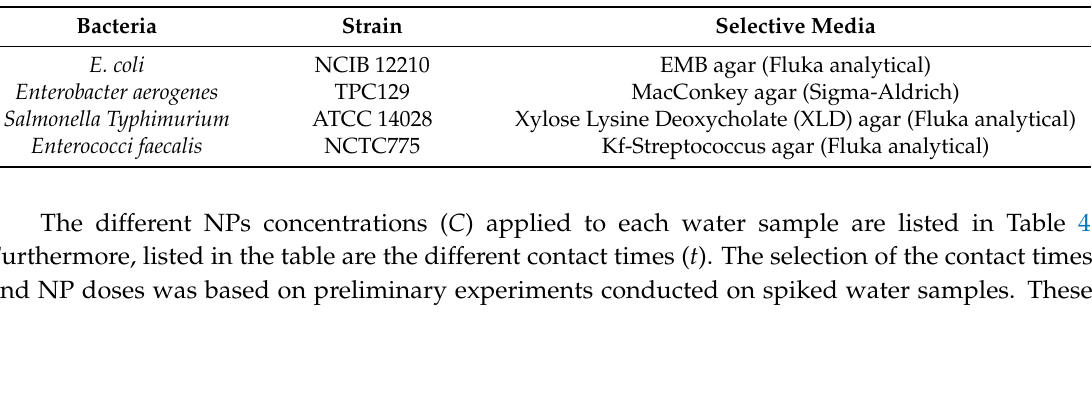
Table 3. Strains and selective media used for the different microorganisms.